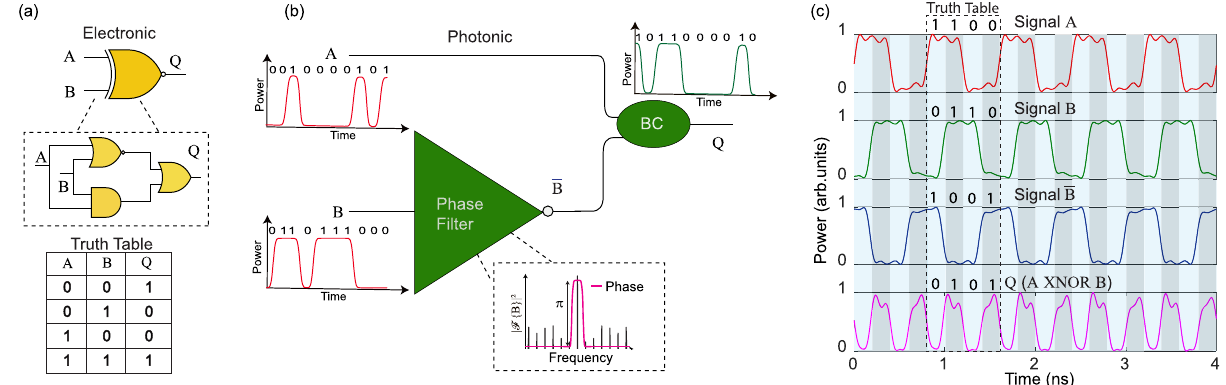
Fig. 3 | Experimental demonstration of XNOR logic based on spectral phase fi ltering. a The simplest implementation of a XNOR logic in electronics require three mixed logic gates, viz., NOR, AND, and OR. The truth table represents the XNORoutput,Q of the binaryinputs Aand B. b The proposedphotonicequivalent XNOR logic, which can be realized using a beam combiner (BC) and a phase fi lter with a single π − phase shift. Thus, a distinctly simple, all- fi bre implementation can be realized using the FBG-based phase fi lter device. B denotes the inversion of signal B. c Measured temporal waveforms corresponding to the inputs and the resultant output for a simple 4-bit sequence. Through a proof-of-concept experi- ment, we show that the proposed all- fi bre implementation indeed follows the